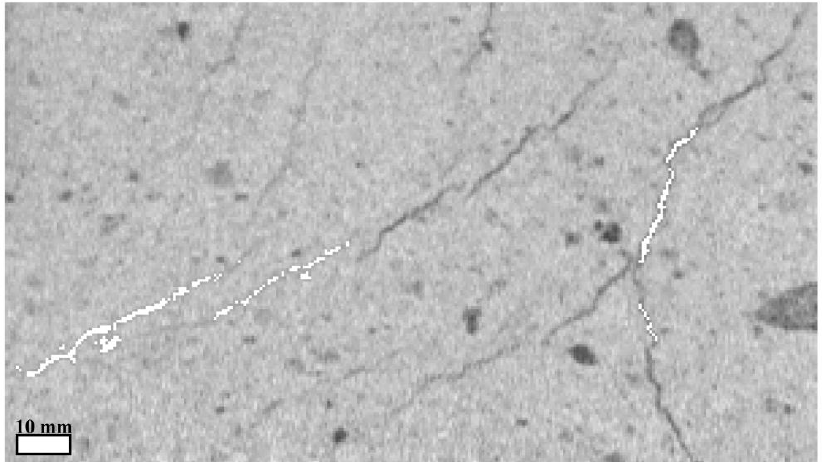
Figure 10. Crack detection results (white regions) with restriction on the investigation box. Image located at mid-width of the anode slice. Left crack: near stub hole. Right crack: near anode slot.